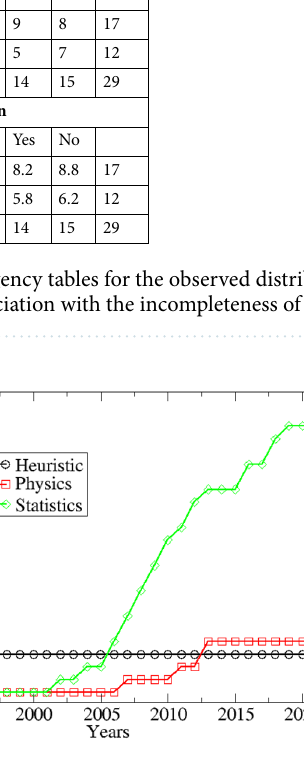
Figure 5. Number of papers accepted and published related to the correlation between magnitude in 23 years. Different curves indicate different types of approach to the